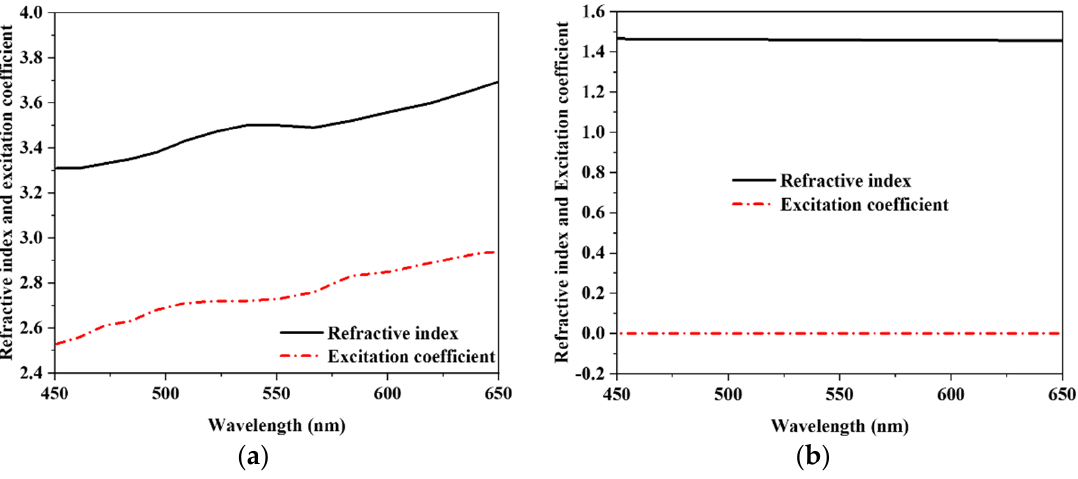
Figure 2. ( a ) Tungsten’s and ( b ) Silicon dioxide’s excitation coefficient and refractive index in the visible optical range.